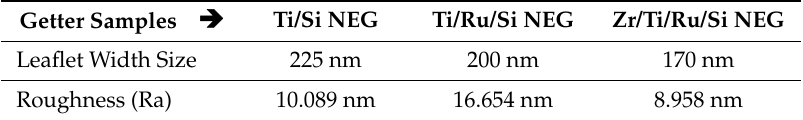
Table 1. Average leaflet width size and NEG upper surface roughness. Getter Samples